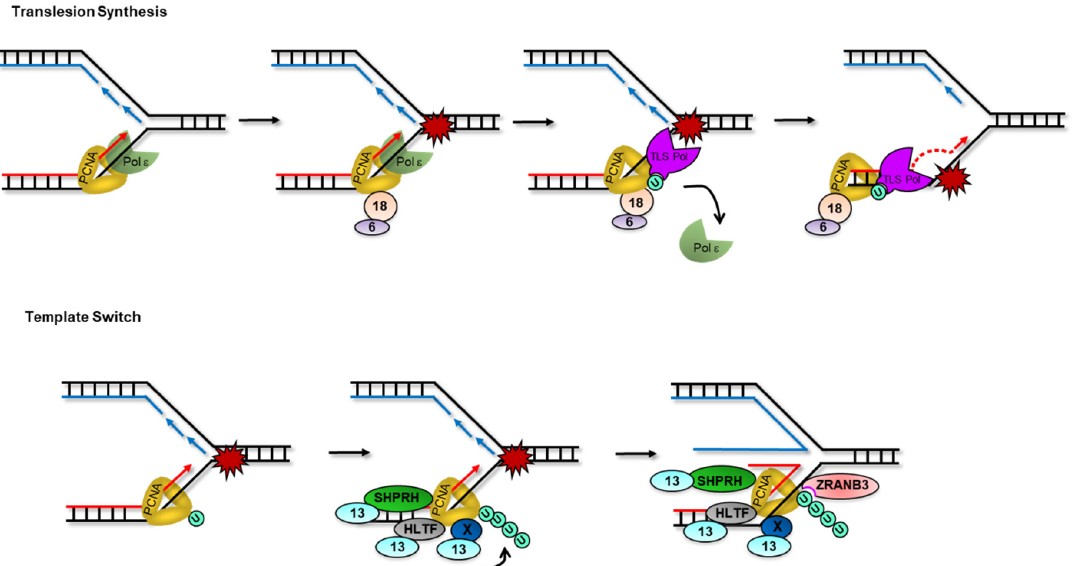
Figure 3. Ubiquitylation on PCNA during Replication Stress. When forks encounter DNA lesions, PCNA is either mono‐ubiquitylated to engage translesion synthesis or poly‐ubiquitylated to trigger lesion bypass by template switching. RAD18(18)‐RAD6(6) is recruited and mono‐ubiquitylates PCNA at K164. Mono‐ubiquitylated PCNA is recognized by specialized TLS polymerases that contain PCNA‐interacting and ubiquitin‐binding domains (e.g., POL η, κ, ι, REV1). TLS polymerases replace replicative polymerases to continue DNA synthesis across the lesions. Addition of K63‐linked ubiquitin chains on mono‐ubiquitylated PCNA is mediated by the UBC13‐UEV1 (13) E2 complex which functions with either HLTF, SHPRH and/or currently unknown E3 ligases (X). Poly‐ubiquitylated PCNA recruits fork remodeler ZRANB3 via its ubiquitin binding zinc finger to allow fork regression.